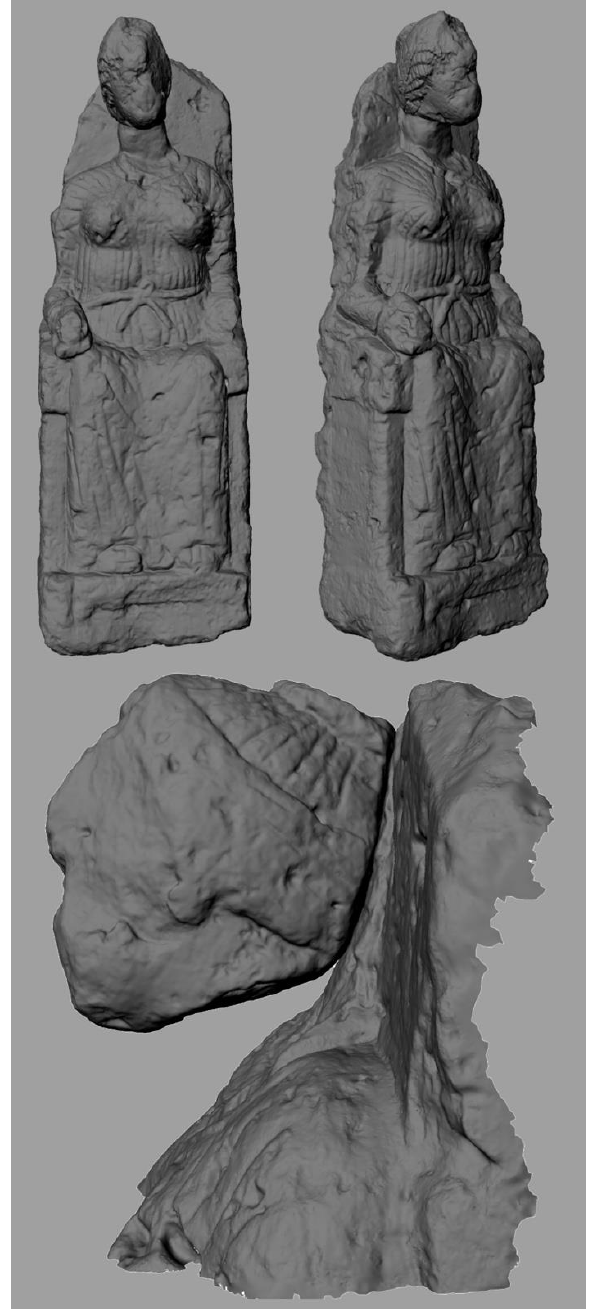
Figure 2. The virtual model of the statue "A" before and after the